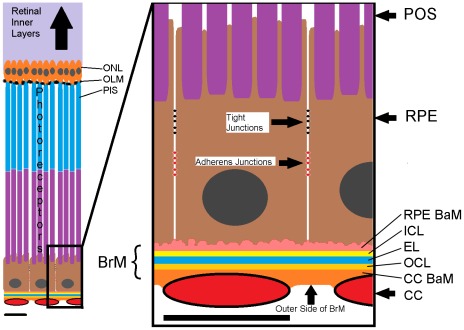
Retinal structure, the retinal pigment epithelium, Bruch's membrane and the choriocapillaris.
Left large-scale: Structure of the outer retinal layers, the RPE and the CC. Right: Detail of the CC-BrM-RPE-POS complex. CC: choriocapillaris, BrM: Bruch's membrane, RPE: Retinal pigment epithelium, CC BaM: Basement membrane of the CC, OCL: Outer collagenous layer, EL: Elastin layer, ICL: Inner collagenous layer, RPE BaM: Basement membrane of the RPE (we abbreviate RPE BaM as RBaM), POS: Photoreceptor outer segment, PIS: Photoreceptor inner segment, ONL: Outer nuclear layer. Light purple shading indicates the location of the inner retina. Scale bars ∼10 µm.